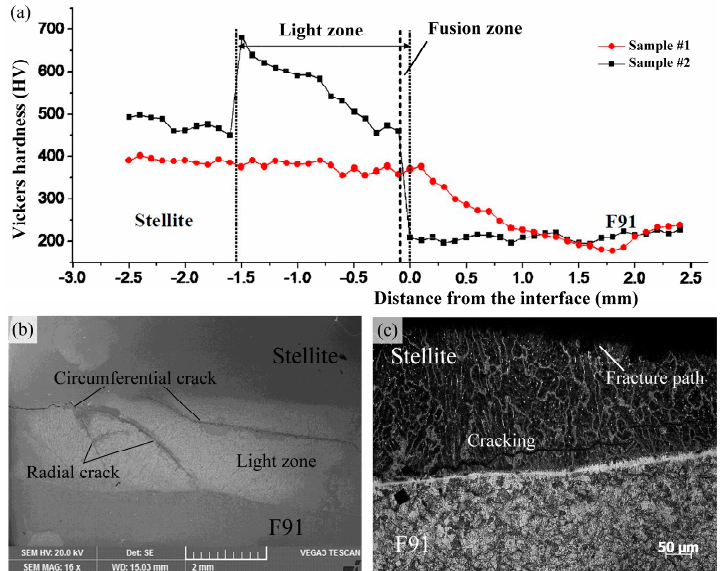
Figure 8. ( a ) Transverse micro-hardness profiles of samples #1 and #2; ( b ) Image of cracks distribution of sample #2; ( c ) Image of fracture paths in partial region of sample #2.